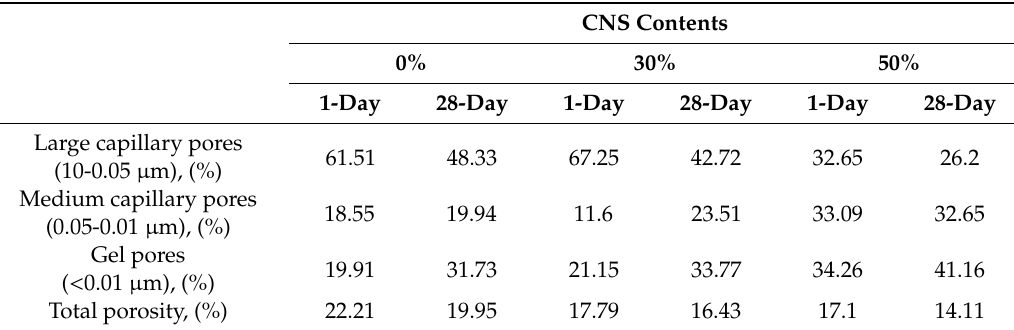
Table 3. Pore size distribution according to the CNS replacement